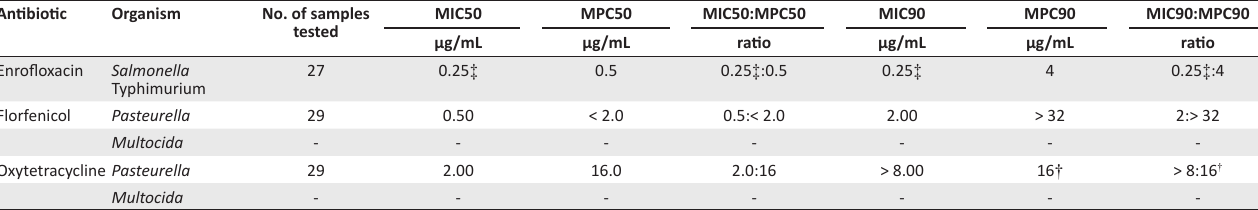
TABLE 3 : Minimum inhibitory concentration and mutant prevention concentration results obtained during current study. Antibiotic Organism